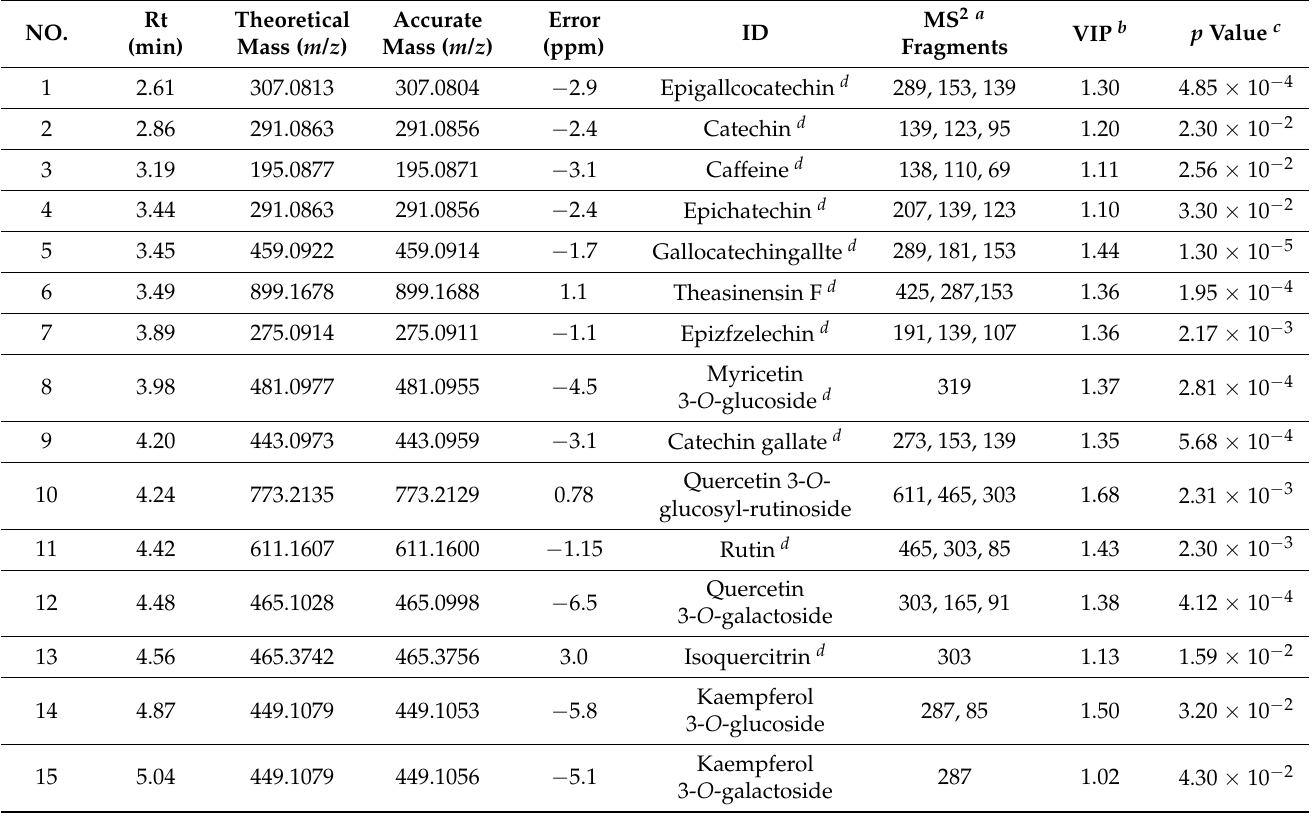
Figure 3. Partial least squares-discriminant analysis (PLS-DA) score plot of primary and secondary metabolites identified by GC-TOF MS and LC-Q-TOF MS. CON, conventional fertilization; OPT, optimized fertilization; OPTM, optimized fertilization supplemented with Mg. Table 2. Statistically important metabolites in different tea samples derived from using UPLC − Q-TOF MS